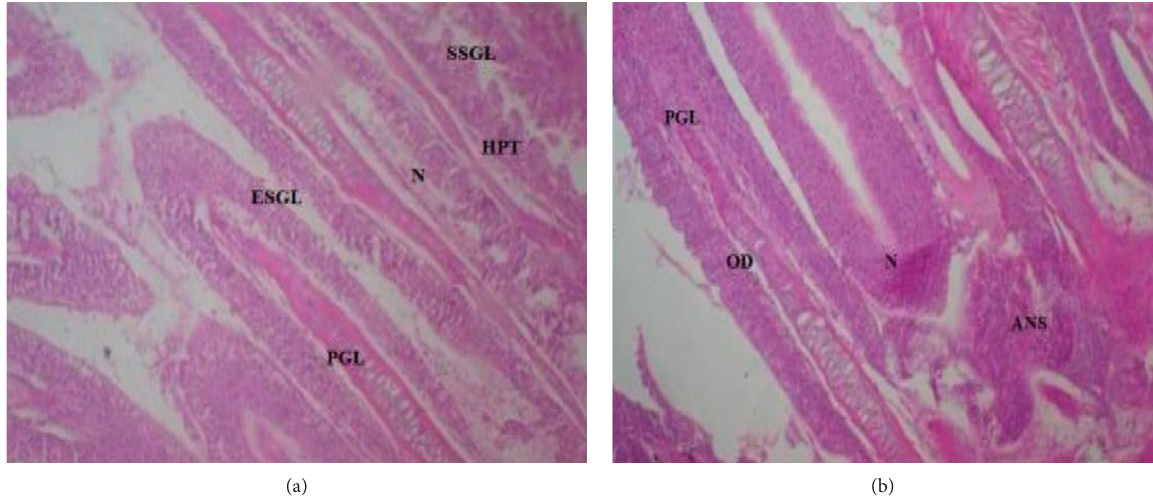
Figure 6: (a) Histological section of gill exposed to bulk SiO/Al 2 O 3 (1:1) showing primary gill lamella (PGL), eroded secondary gill lamella (ESGL), and hypertrophy (HPT). Shortened secondary gill lamella (SSGL) and area of necrosis (N) are also observed (H&E stains, × 100). (b) Histological section of gill exposed to bulk Al 2 O 3 /CuO (1:1) showing primary gill lamella (PGL), total destruction of secondary gill lamella, oedema (OD), aneurysm (ANS), and necrosis (N) (H&E stains, ×